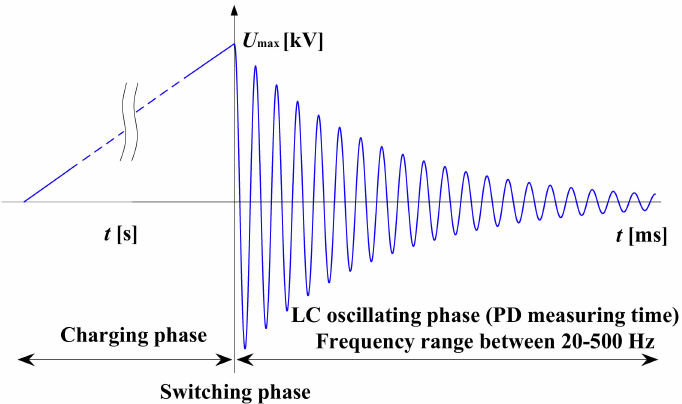
Figure 5. Schematic view of damped AC (DAC) excitation.